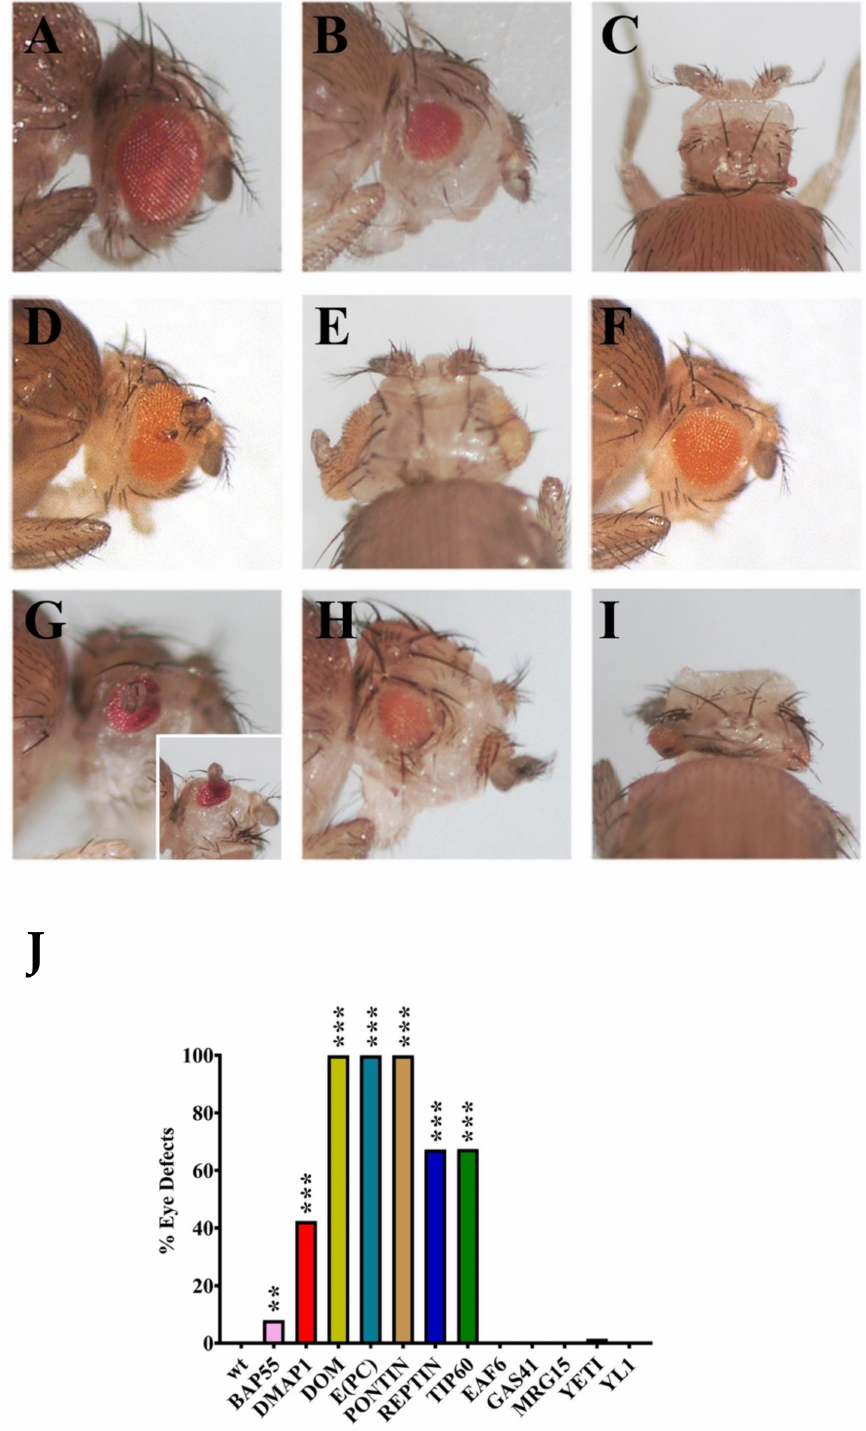
Figure 4. Eye morphology and differentiation defects after silencing of genes coding for dTip60 complex subunits. ( A ) Wild-type control; ( B , C ) silencing of DMAP1 coding gene caused eye reduc- tion and microcephaly, respectively; ( D , E ) simultaneous silencing of DOM-A and DOM-B caused eye reduction and formation of extra-growths; ( F ) eye reduction after E(PC) silencing; ( G ) PONTIN silencing caused eye reduction and formation of extra-growth; ( H ) strong eye reduction; and ( I ) mi- crocephaly after REPTIN silencing; ( J ) quantification of eye defects. p value <0.005 (**) or p value <0.0005 (***), compared with the control